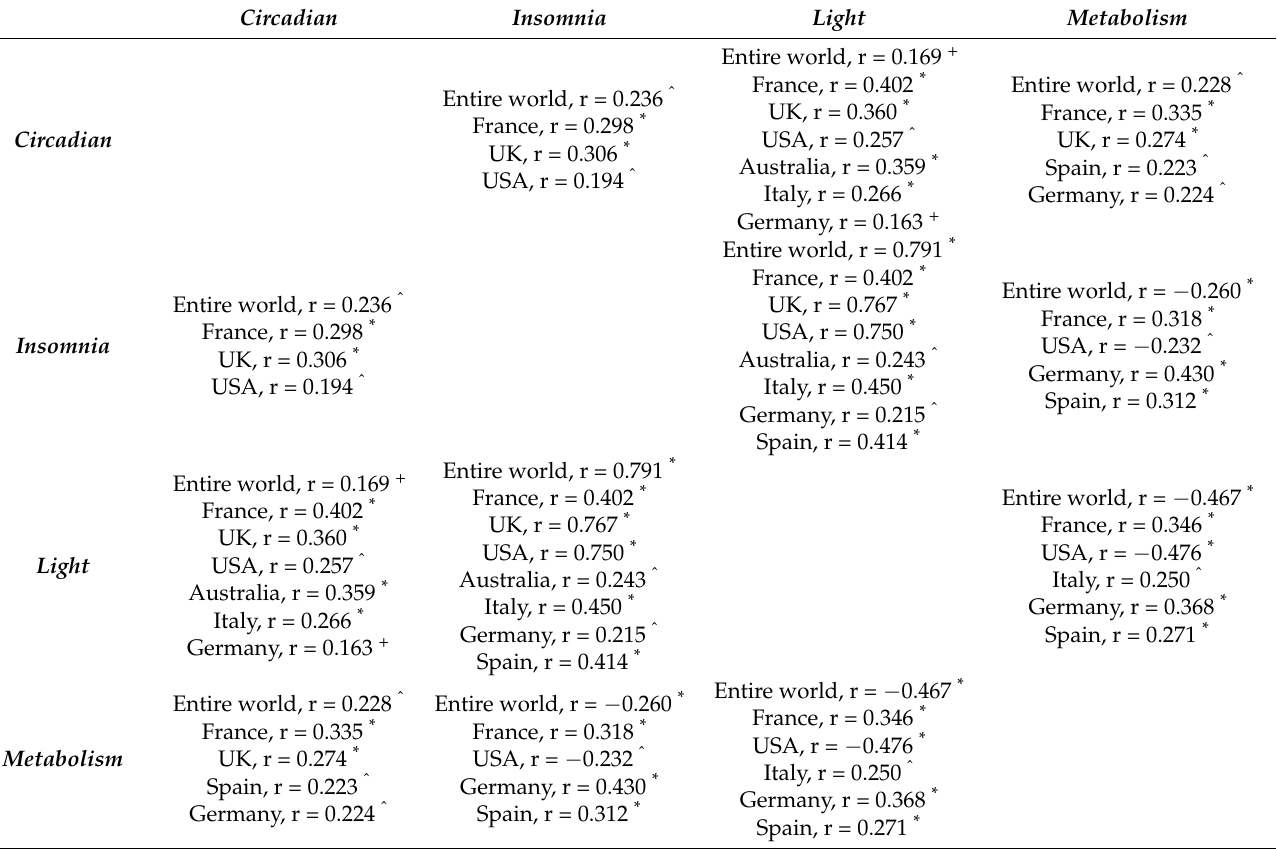
Table 3. Pearson’s coefficients of the natural logarithm of the relative search volume associated with circadian, insomnia, light, and metabolism derived from analysis of the entire world and of the different countries. Circadian Insomnia